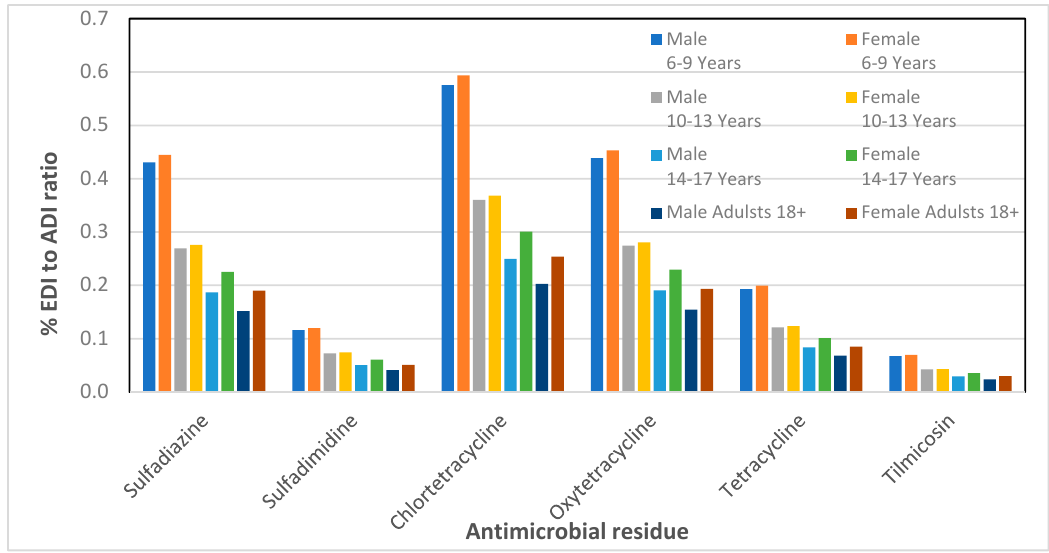
Figure 1. Percentage of estimated daily intake (EDI) to acceptable daily intake (ADI) ratio for six veterinary antibiotic residues found in pork meat for children, adolescents, and adults of the Cypriot population.